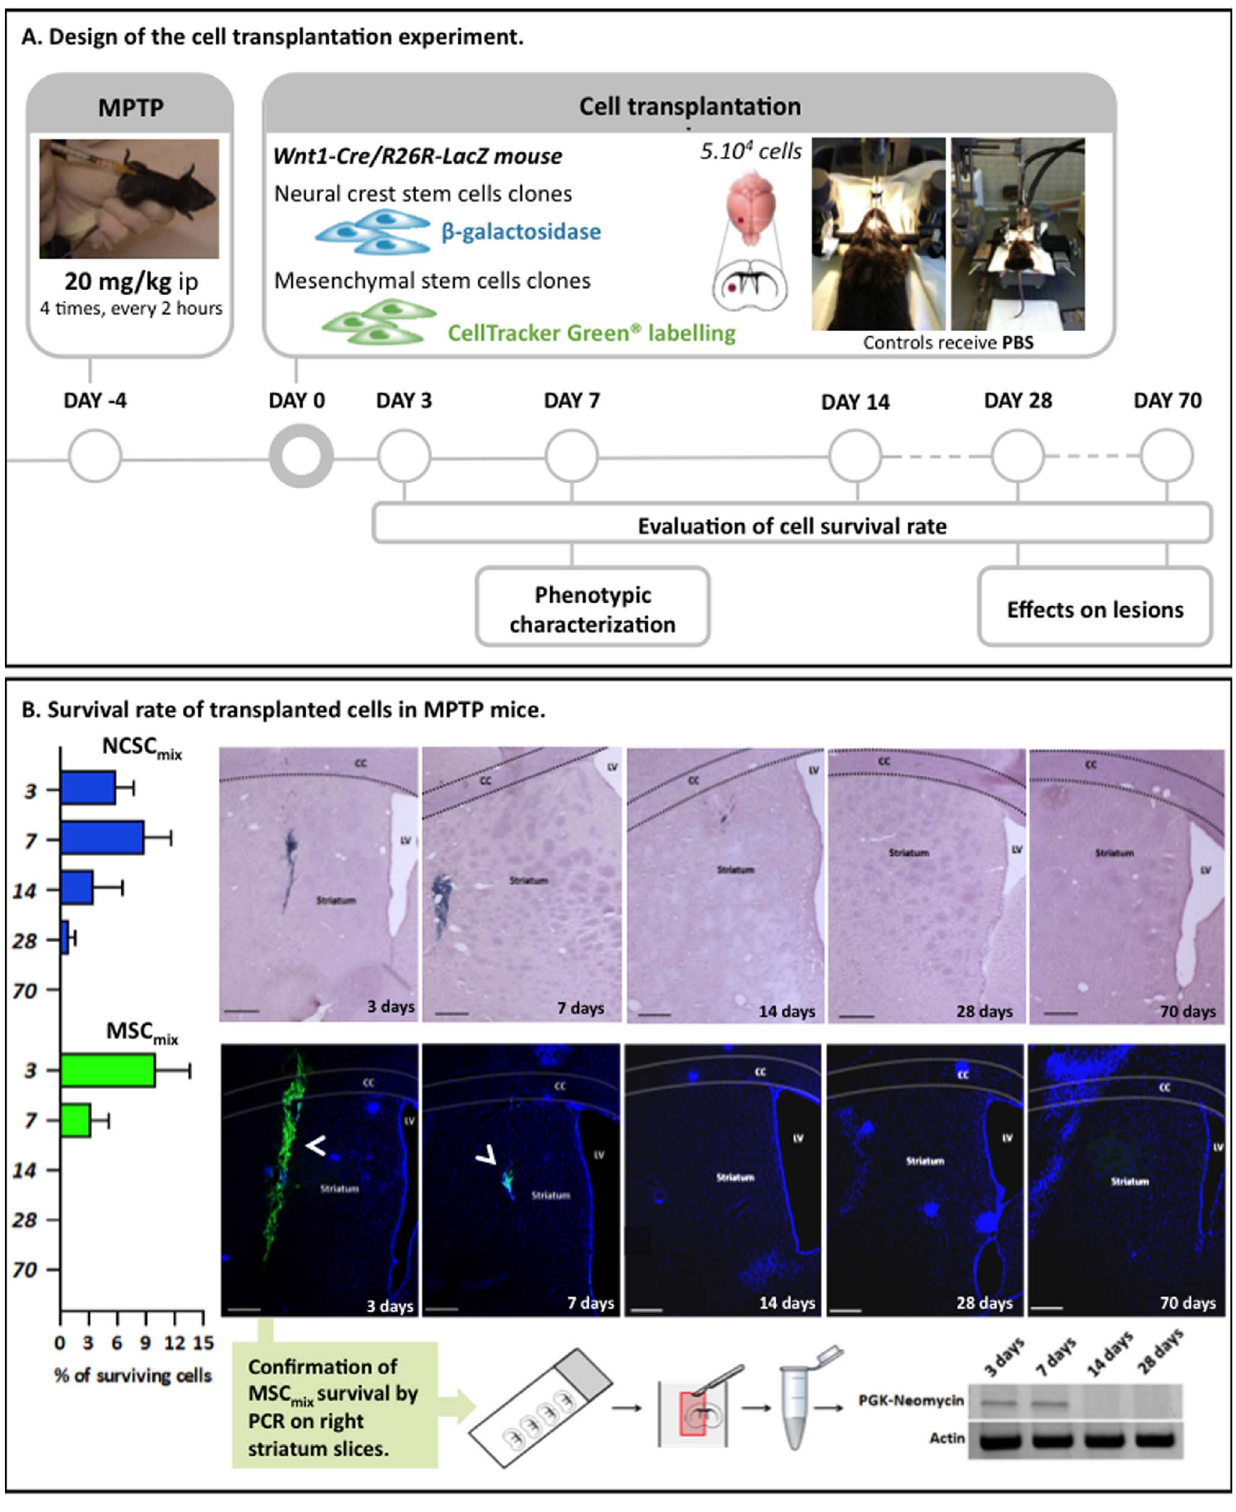
Figure 3. Intrastriatal transplantation of MSC mix /NCSC mix in MPTP mice and survival rate of grafted cells at 3, 7, 14, 28 and 70 days after transplantation. A. Experimental design of the lesion and transplantation experiment. Adult C57Bl/6J male mice were injected with MPTP following the ‘‘classical’’ acute regimen. Five days after MPTP treatment MSC mix /NCSC mix were injected into the right striatum of mice (MSC mix were first stained with Cell Tracker Green in order to be detected in vivo ). Survival rate evaluation and phenotypic characterization were performed at different delays post-graft. B. The number of surviving NCSC mix in the right striatum ( blue X-gal staining and purple Hematoxylin-stained nuclei) can reach 15% in the first week after transplantation, then the cells begin to disappear and after 4 weeks, we only observe a mean survival rate of 1%. Results are expressed in %, according to the 5 6 10 4 injected cells (Mean 6 SEM). MSC mix ( green CTG staining, blue DAPI-stained nuclei) seem to